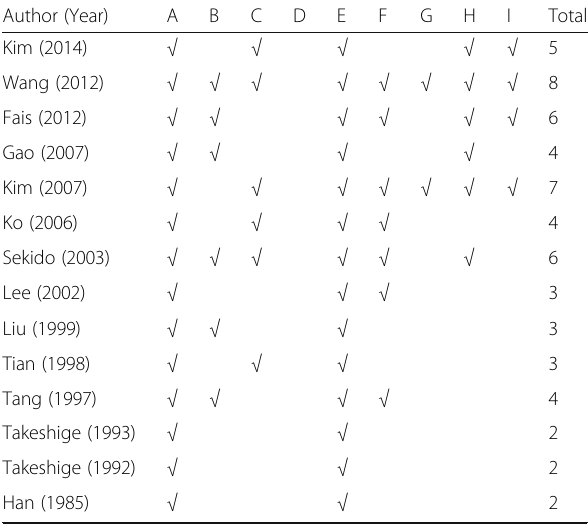
Table 2 Risk of bias of the included